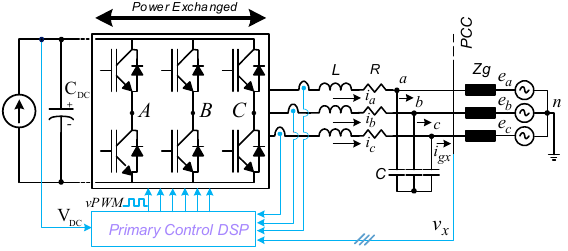
Figure 1. Grid ‐ connected two ‐ level three ‐ phase three ‐ wire voltage source converter.